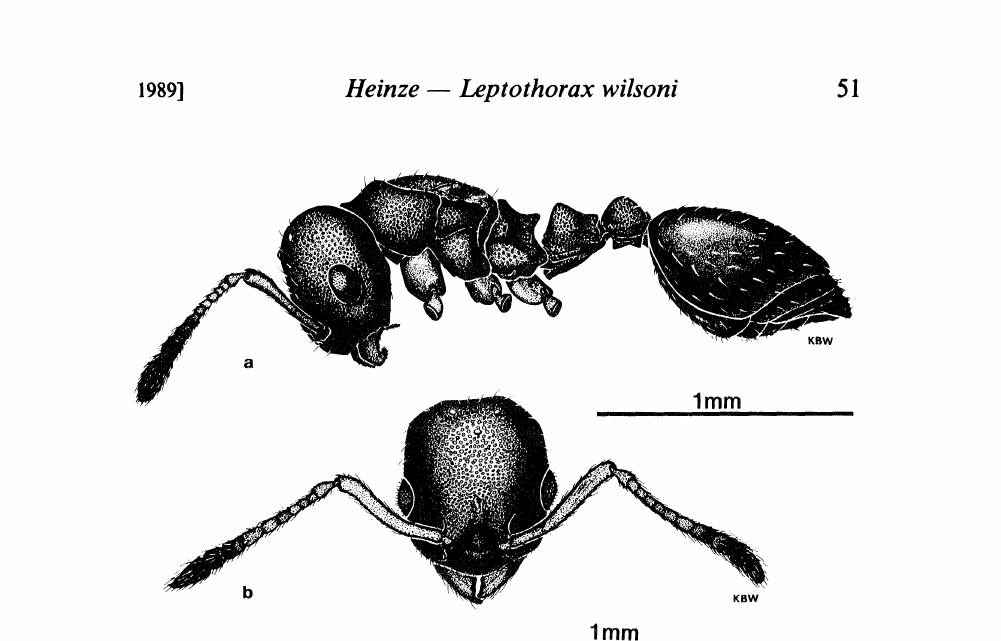
Fig. 1: lntermorphic female of Leptothorax wilsoni in lateral view (1a) and head in frontal view (lb). seen in intermorphic females of Harpagoxenus sublaevis or